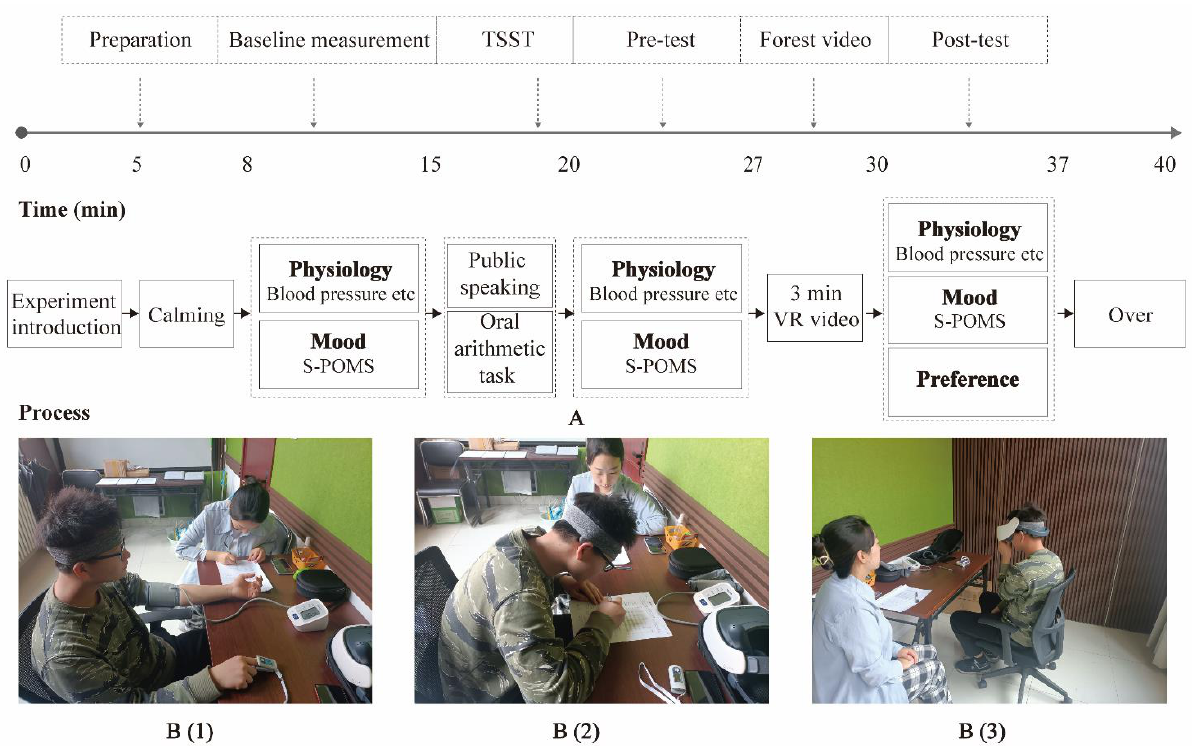
Figure 2. Experimental process: ( A ): experimental timeline; ( B ): experimental site. Note: Informed consent was given by the participants for the publication of identity revealing images in an online open-access publication.